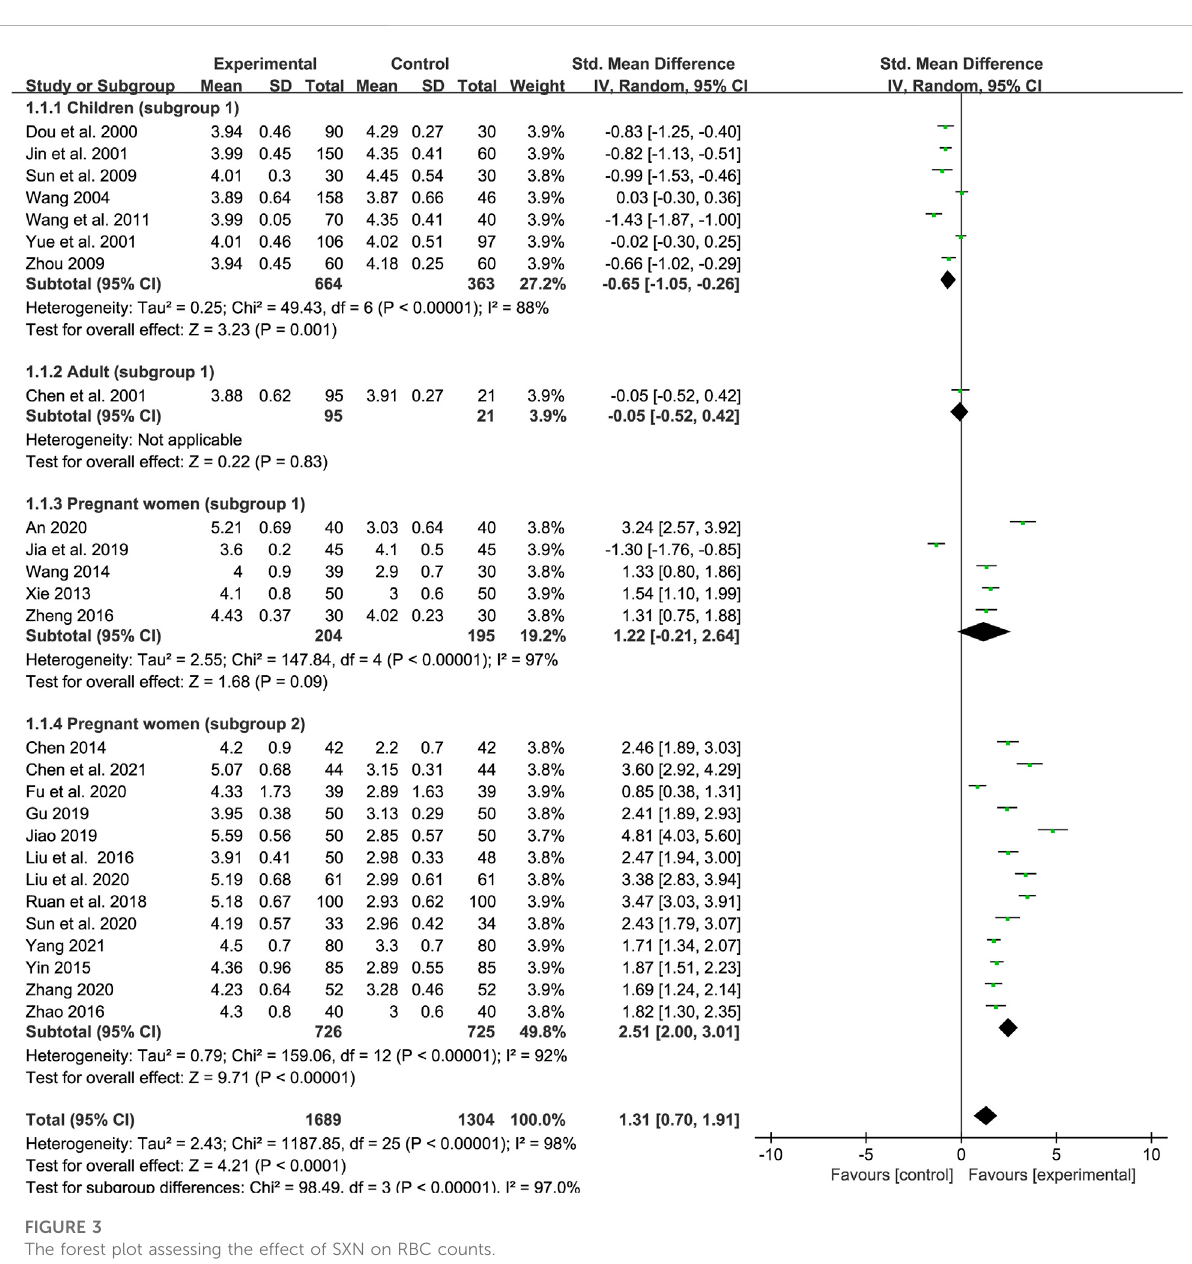
further identify the effect of SXN on Hb, the data showed that SXN treatment in combination with an iron supplement all exhibited superior ef fi cacy in increasing Hb levels when compared with different iron supplementation monotherapies, and the differences were all statistically signi fi cant (Supplementary Table S4). Sensitivity analysis indicated that the total effect size in different population groups were stable (Figures 9D – G) and no publication bias was observed based on Egger ’ s test in each population group [ p = 0.872 in children; p = 0.071 in adults; p = 0.076 in pregnant women (subgroup 1); and p = 0.093 in pregnant women (subgroup 2)].